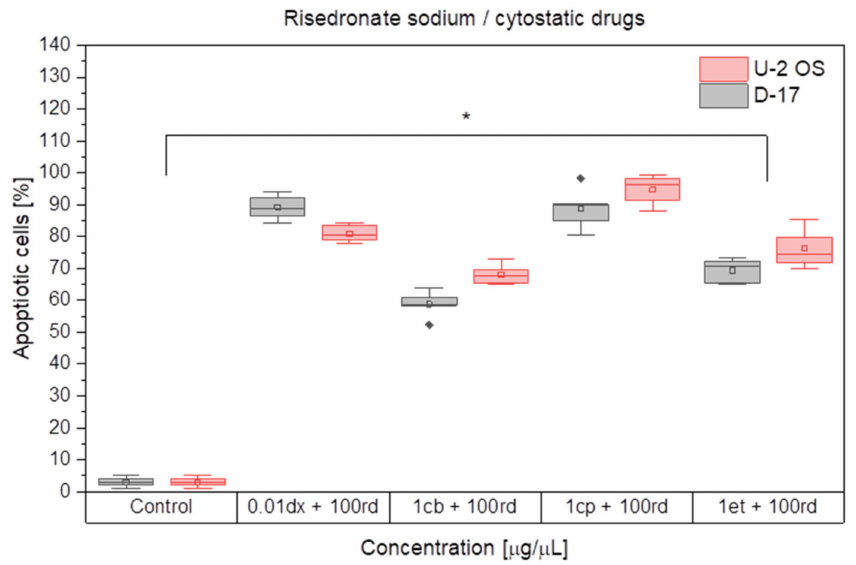
Figure 4. The effect of combinations of cytostatic drugs and risedronate sodium on the apoptosis in canine and human osteosarcoma cell lines. dx—doxorubicin, cp—cisplatin, cb—carboplatin, et— etoposide, rd—risedronate sodium, rhombus—outliers, * ( p <